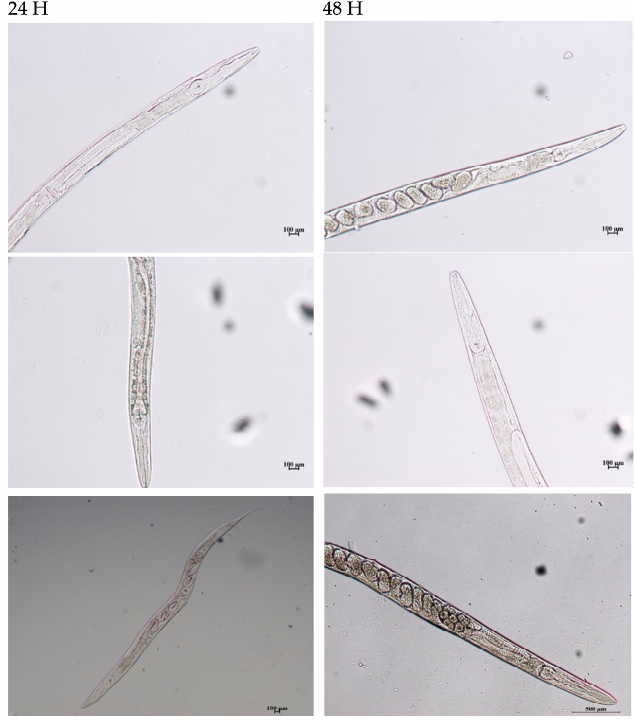
Figure 4. Status of model animal, C. elegans , during biopolymer treatment. Young adult C. elegans controls. Representative images showing the spatiotemporal (20 × ) effect of the E. hirae biopolymer on the model animal, C. elegans , when compared to the control OP50 (food source, bottom Left (24 H) and Right (48H).In the biopolymer-treated animals exposed to daidzein, delayed production of eggs was initially observed but subsequently normalcy was